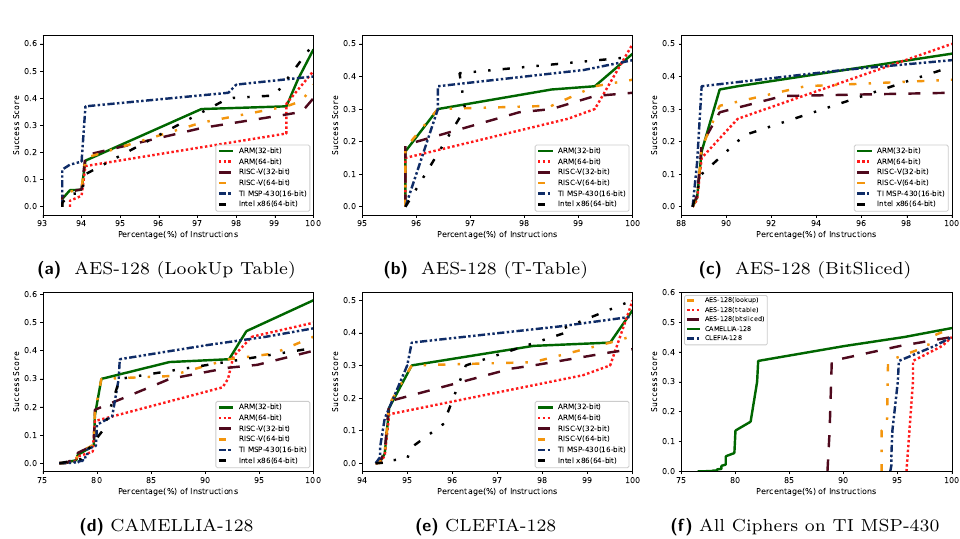
Figure 12: Percentage of vulnerable instructions for different cipher implementations. To understand these graphs, consider for example in Figure (d), when x = 85%, y = 0 . 38 on TI MSP-430(16-bit). This means that 85% of CAMELLIA-128 instructions have SuccesScore ≤ 0 .